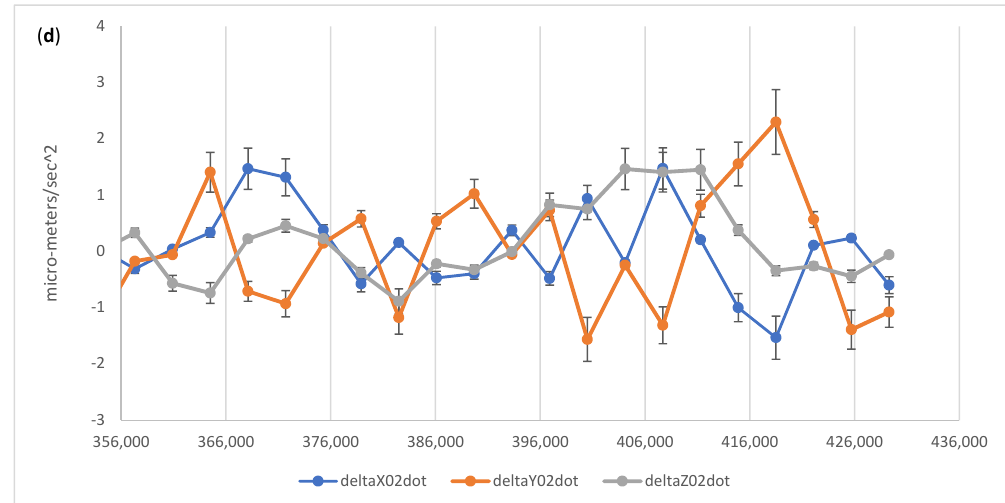
Figure 12. Corrections to the broadcast ( a ) clock, ( b ) positions, ( c ) velocities, and ( d ) lunisolar accelerations for R01 using CNES precise orbits as reference. The vector of state (3 clock parameters + 9 orbit parameters) is estimated at intervals of 1 h. Rate of clock drift (a 2 ) was computed but is not shown.